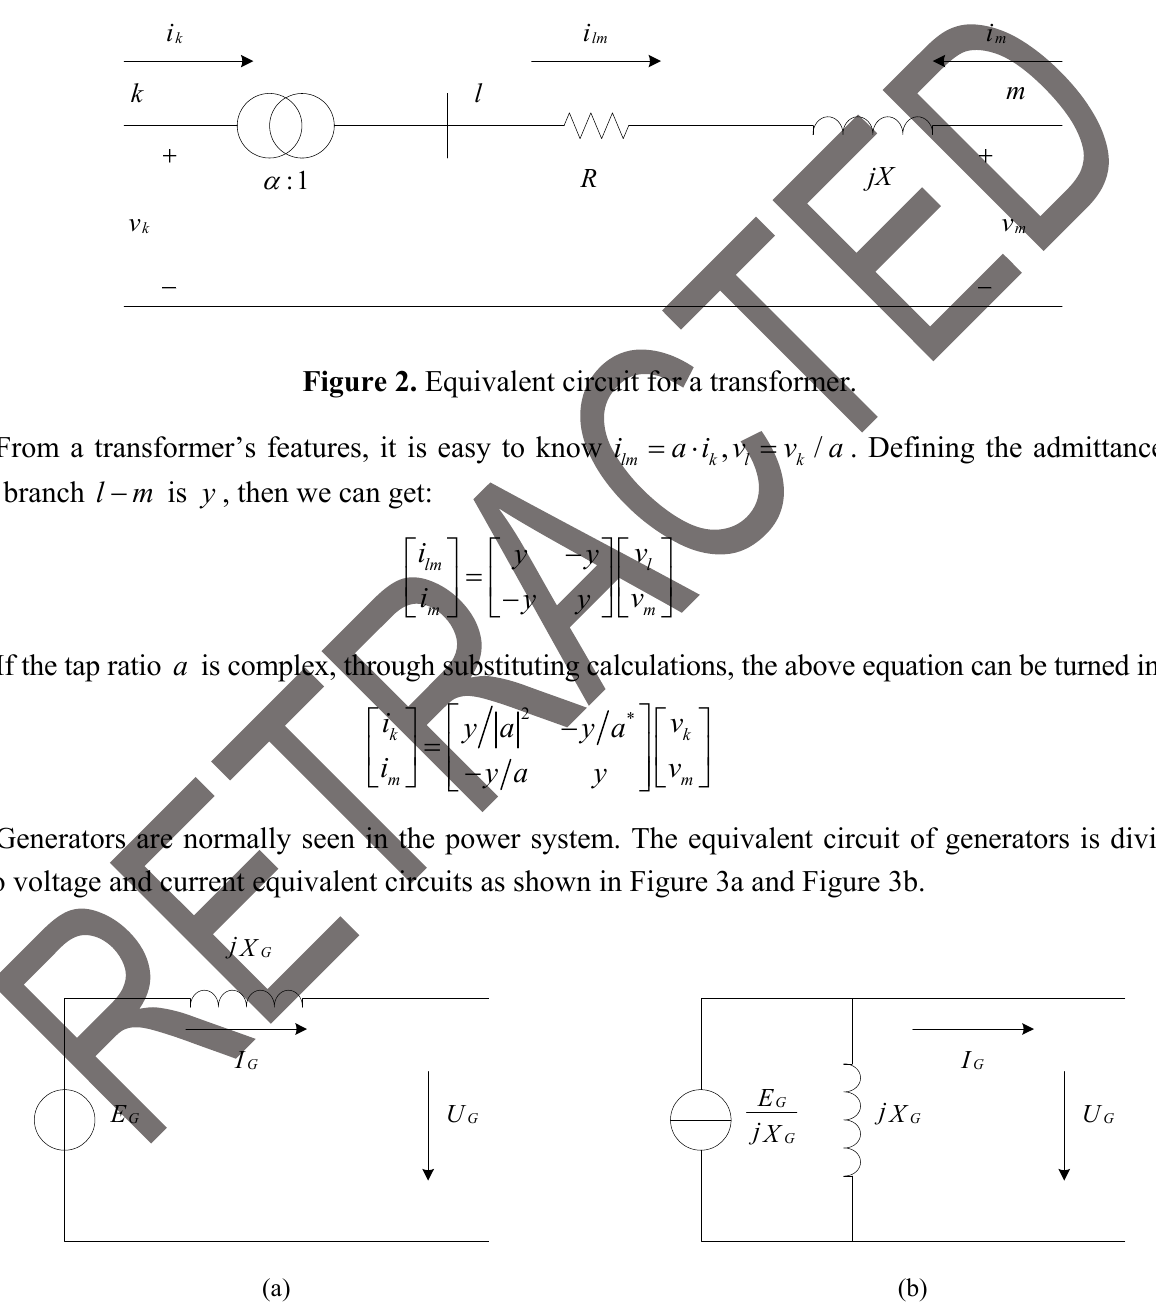
Figure 3. Equivalent circuit for a generator. ( a ) Voltage equivalent circuit for a generator; ( b ) Current equivalent circuit for a